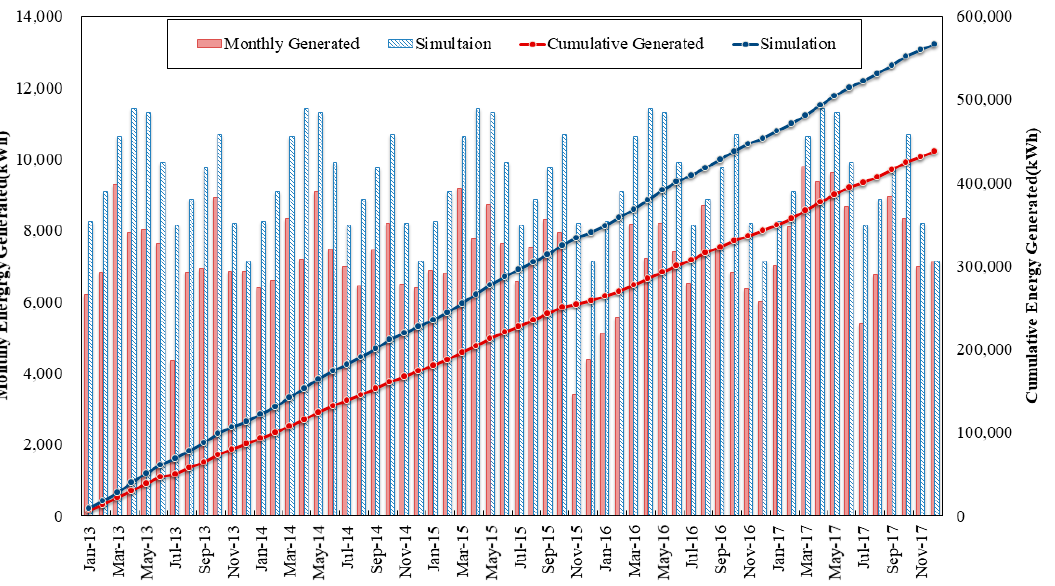
Figure 6. Comparison of measured and simulated five-year and monthly energy production values.